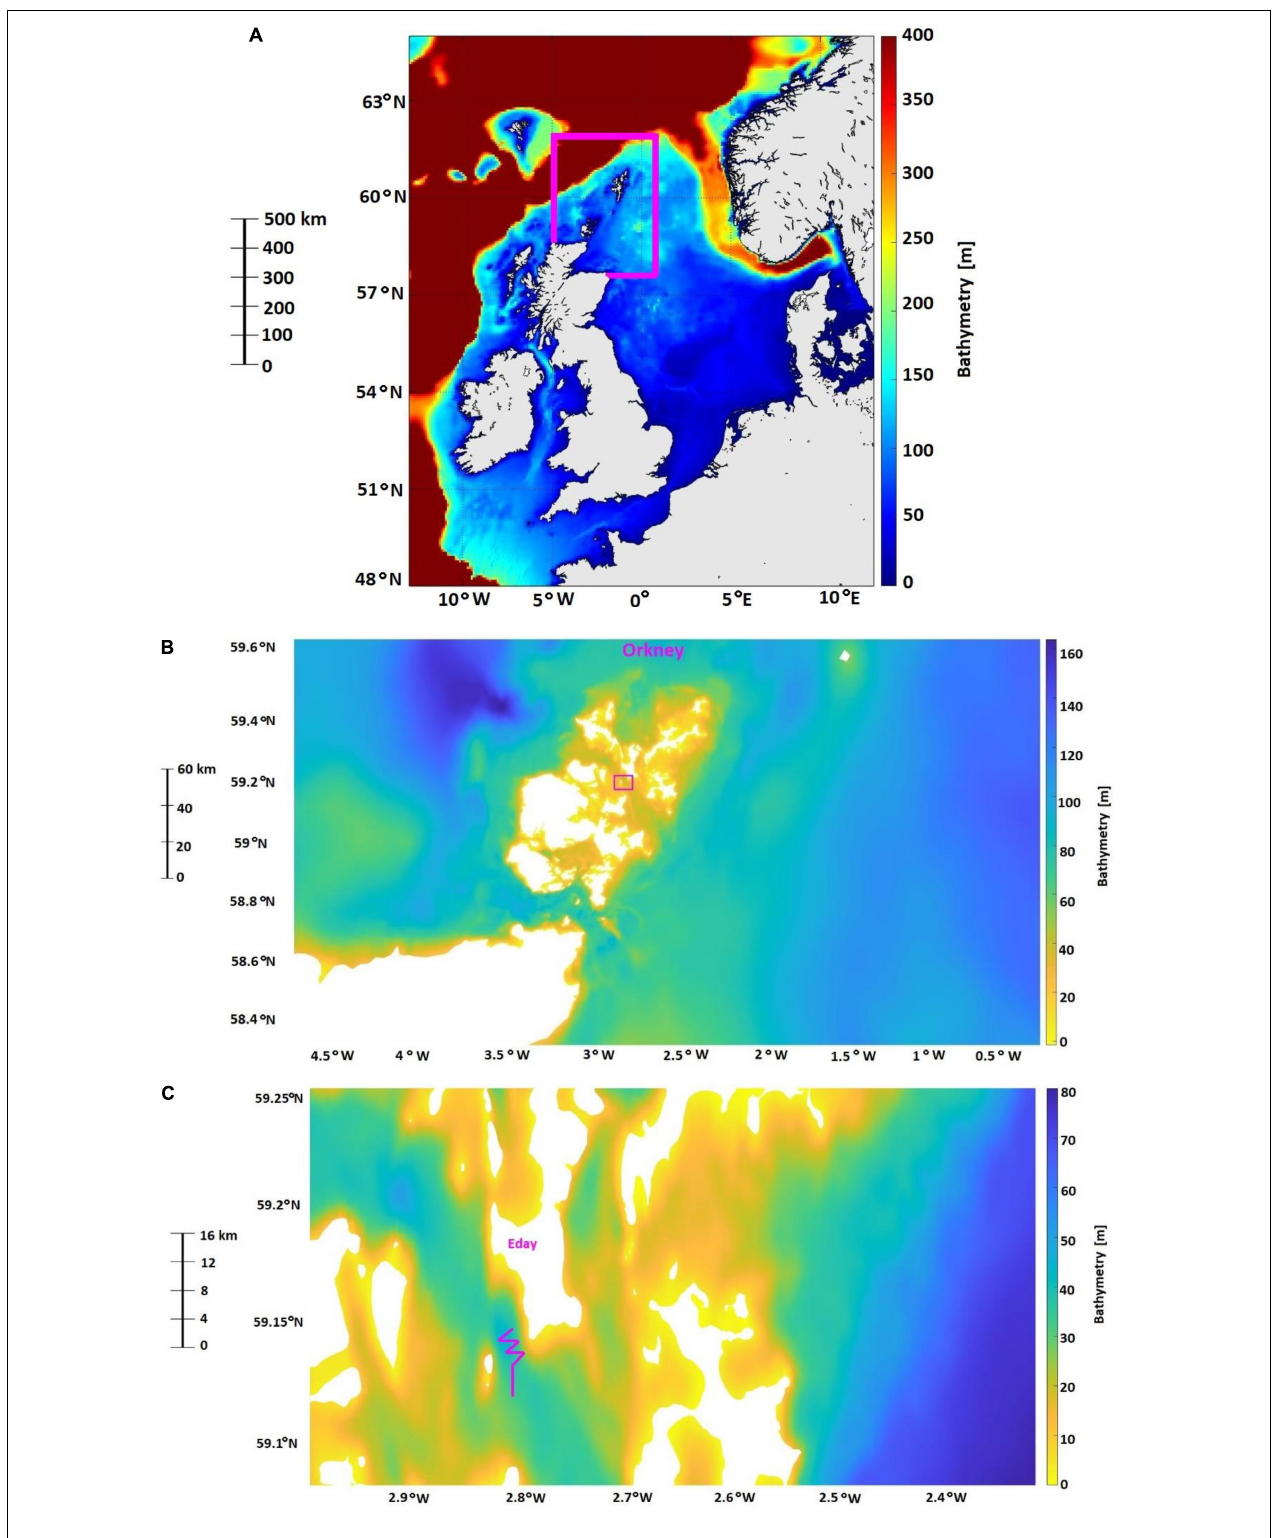
FIGURE 4 | The North Sea and the United Kingdom continental shelf and the spatial boundaries of Shetland and Orkney region (highlighted in purple) to represent the shallow shelf sea and regional scales (A) , respectively, as defined in this work, the archipelago of Orkney as a representation of the local scale (B) and the island of Eday and an example of vessel-based transects, based on Waggitt et al. (2016b), as a representation of the fine scale (C) .